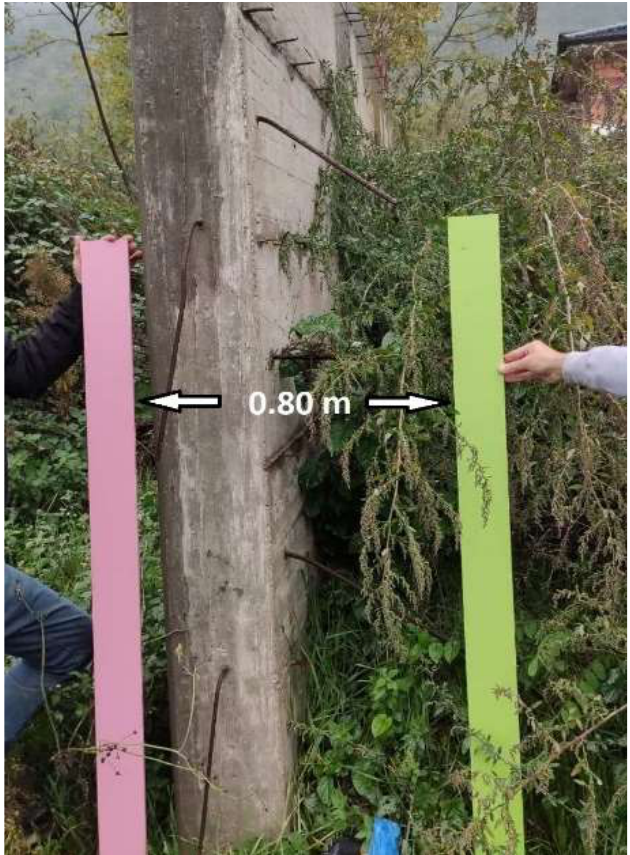
Figure 11. Example of differences in the location of boundary points: (red) calculated coordinates from the survey data; (green) coordinates from the vectorised cadastral map.